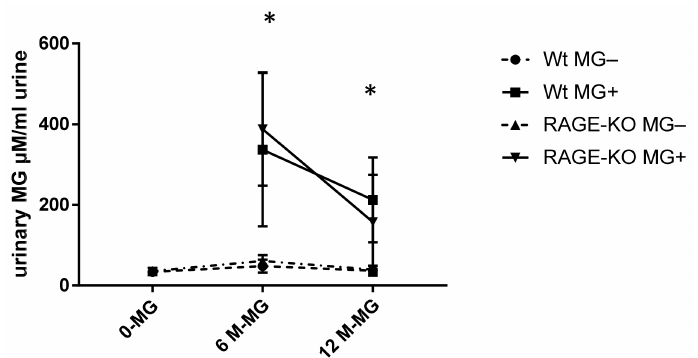
Figure 4. Urinary methylglyoxal (MG) measured with HPLC and normalized on creatinine in urine of wild type (WT) and RAGE knockout (RAGE-KO) mice after supplementation with MG for 6 and 12 months. There was a significant difference between MG amount excreted in fed mice to the controls having tap water; p < 0.001. In addition, after 6 months feeding, the excreted MG in urine was significantly higher than after 12 months * p < 0.05. Data are shown as mean SD ( n = 10–12 for each genotype, group, and time point). Means were statistically compared by two-way ANOVA followed by Sidak’s multiple comparison test.